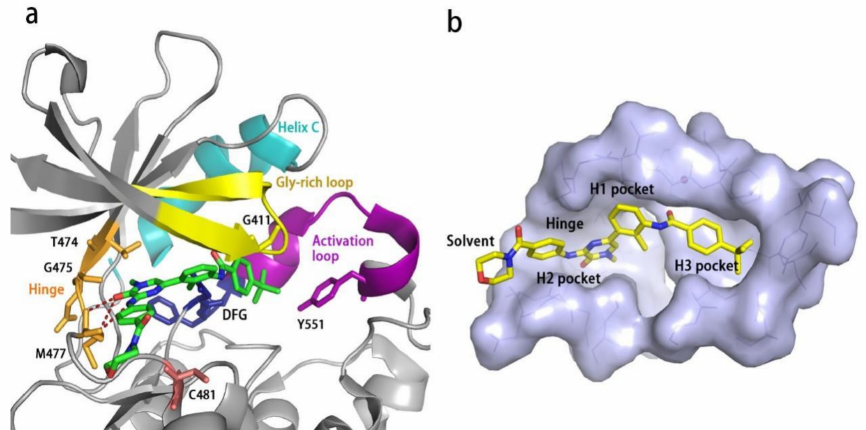
Figure 5. ( a ) X-ray crystal structure of CGI-1746 bound in BTK (PDB code: 3OCS) in cartoon representation. CGI-1746 is shown as sticks and the carbon atoms are depicted in green. ( b ) Illustration of the location of key regions of BTK when bound to inhibitor CGI-1746. Surface view of the binding site is composed by the residues within 5 Å of CGI-1746. All structural images were created using PyMoL